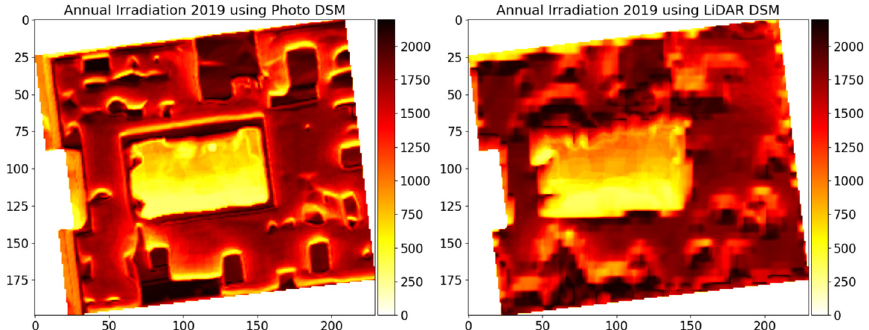
Figure 7. Annual horizontal irradiation on the building 42 rooftop in 2019 (kWh m − 2 ).